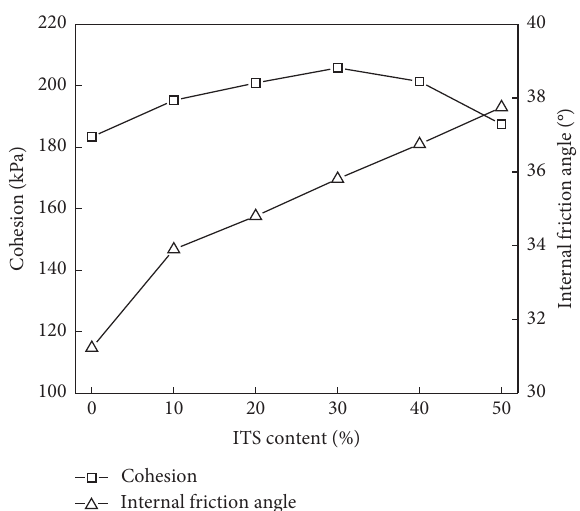
Figure 7: Variations of the cohesion and internal friction angle with ITS